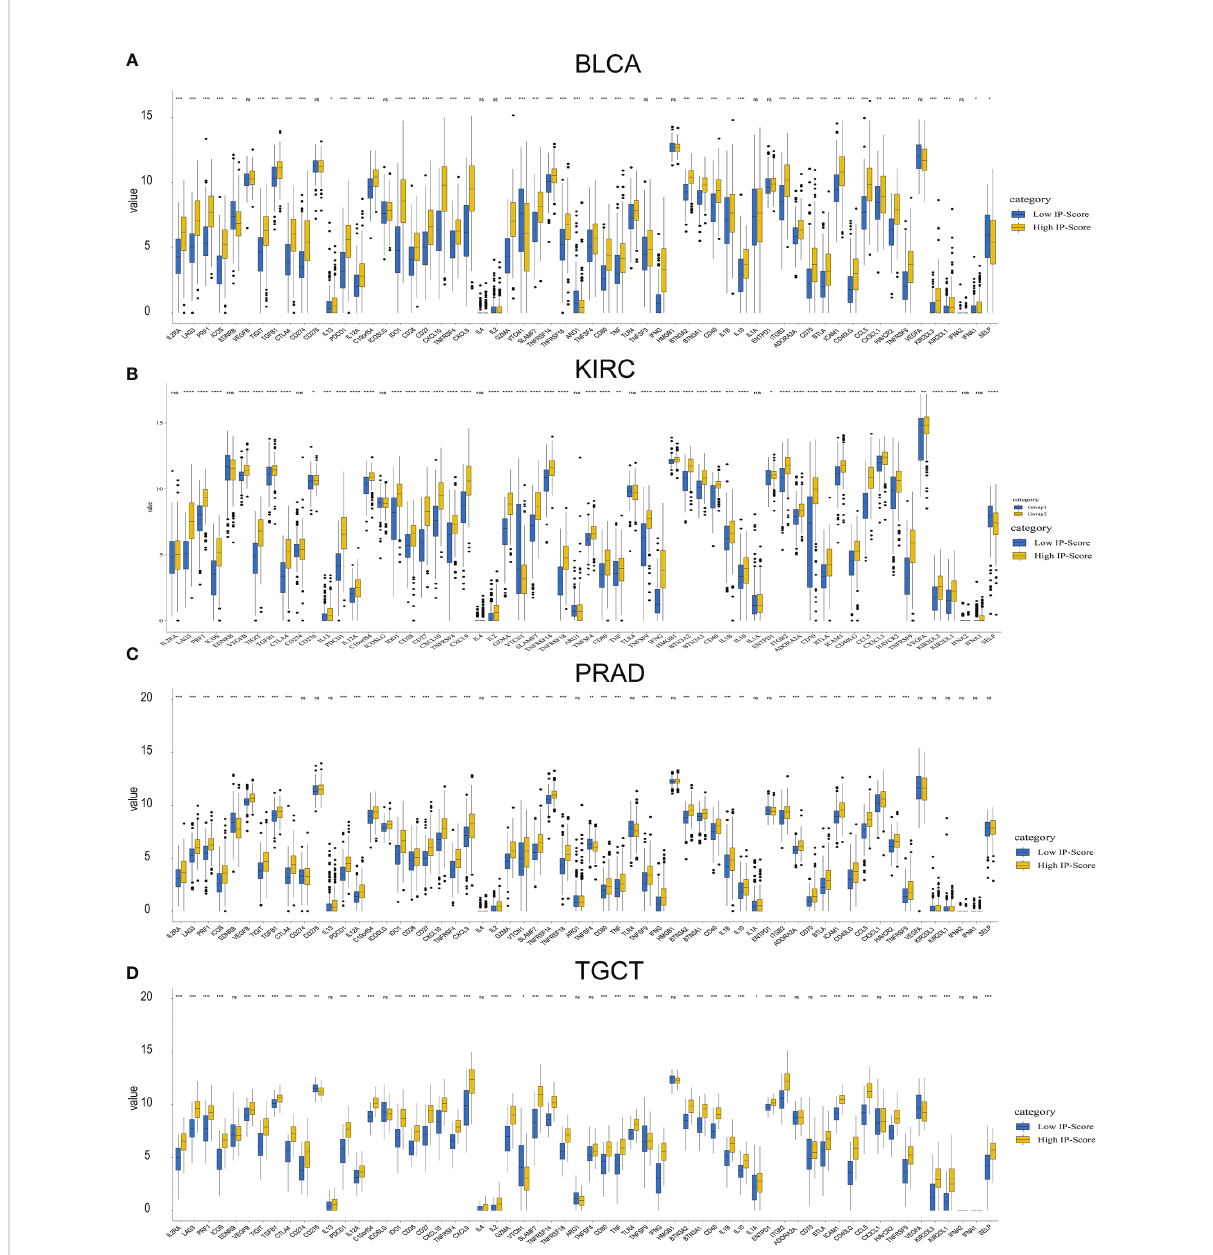
FIGURE 9 Immune check point expression difference between low ip-score and high ip-score. (A) Bladder carcinoma (B) Kidney renal clear cell carcinoma (C) Prostate carcinoma (D) Testicular Germ Cell Tumors. * represent p<0.05; ** represent p<0.01; *** represent p<0.001; **** represent p<0.0001; ns, represent non signi fi